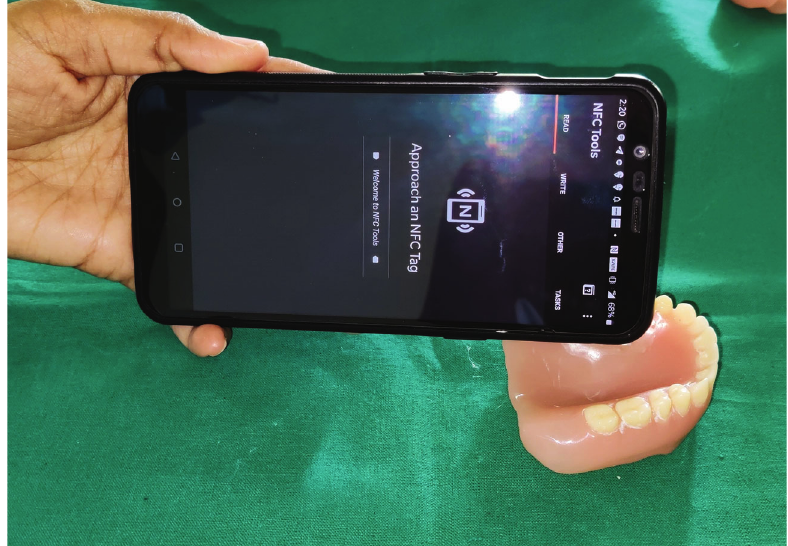
Figure 7: Approaching NFC